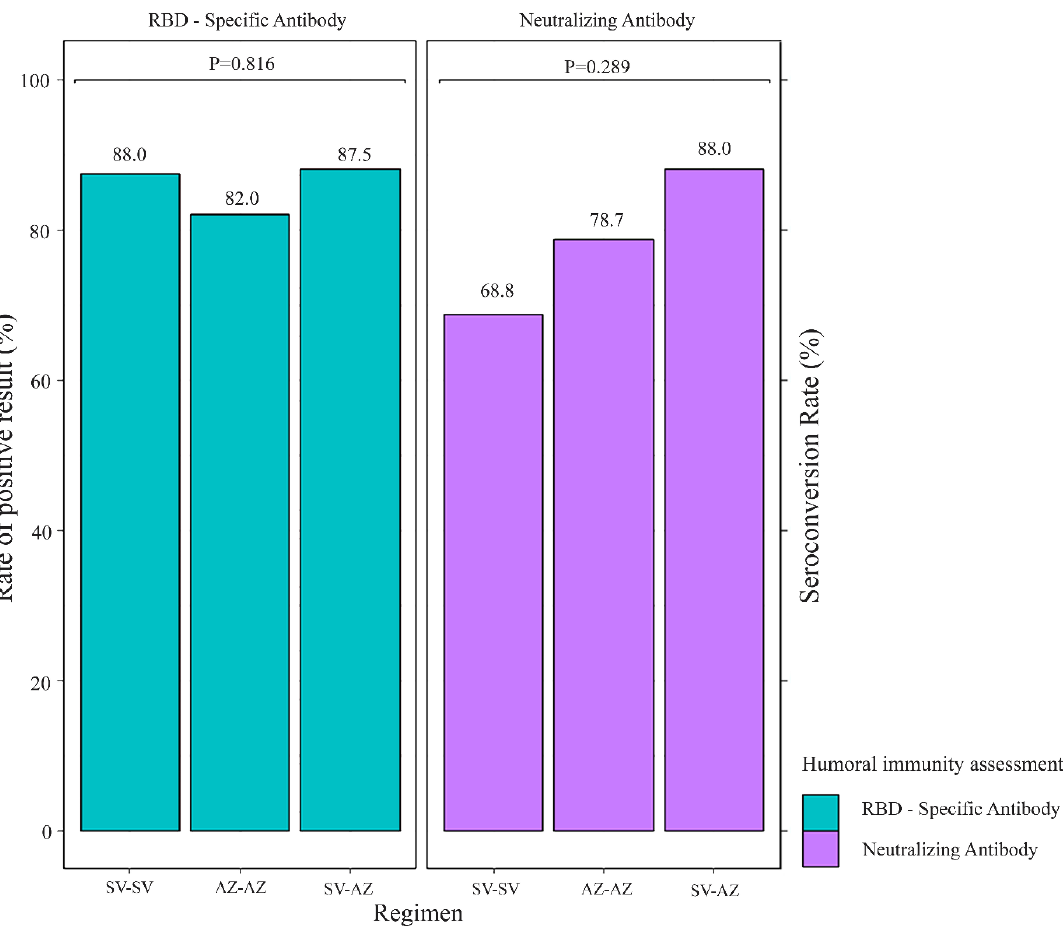
Figure 2. Rate of positive results by anti-spike RBD-IgG antibodies and seroconversion rates assessed by SARS-CoV-2 surrogate virus neutralization test on day 28 after the complete course of each vaccine regimen among MHD patients.AZ-AZ, homologous AZD1222 regimen; SV-AZ, heterologous Sinovac-AZD1222 regimen; SV-SV, homologous Sinovac regimen.